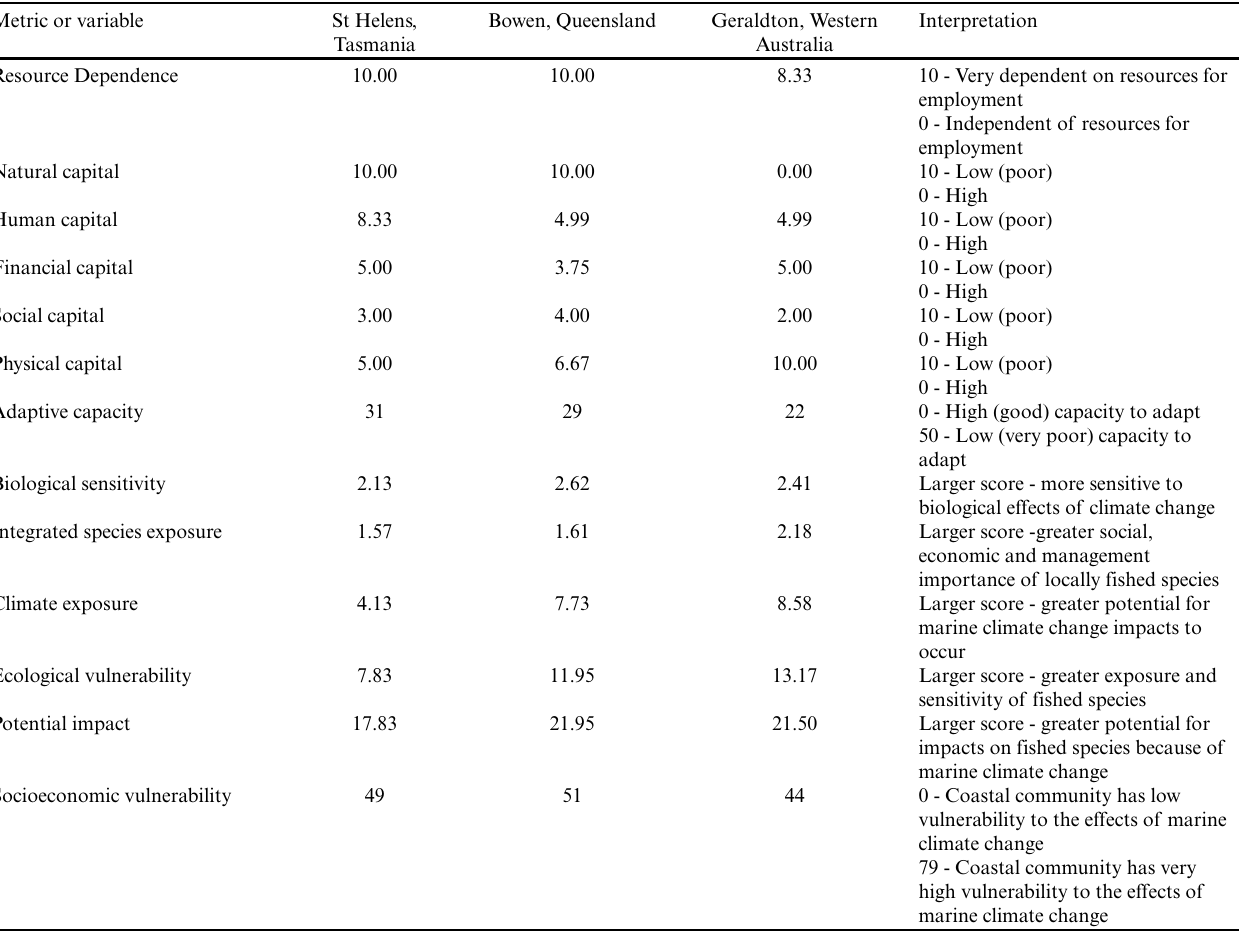
Table 7 . Case study results contributing to the calculation of adaptive capacity and socioeconomic vulnerability to marine climate change impacting coastal livelihoods. Adaptive capacity and socioeconomic vulnerability scores have been rounded to the nearest whole